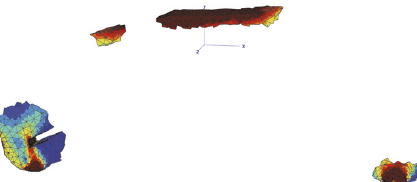
Figure 7: G ∗ is in red; the closest ideal mesh is G4 in grey.